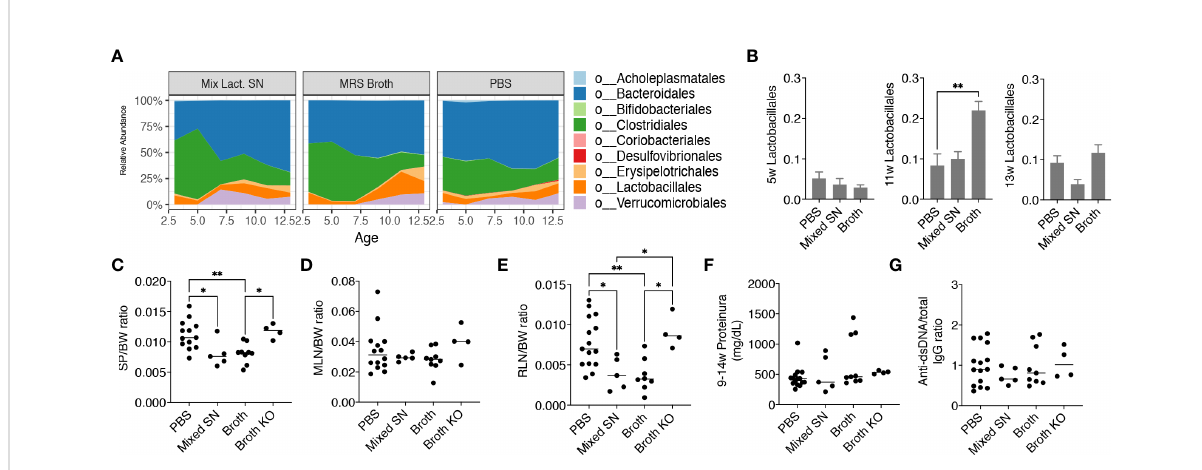
FIGURE 3 Lactobacillus spp. attenuate splenomegaly and renal lymphadenopathy through secreted factors and a CX 3 CR1-dependent mechanism. Female MRL/ lpr mice were orally gavaged with PBS, the combined culture supernatant of the 5 Lactobacillus spp. (Mixed SN), or MRS broth (Broth) twice a week at 200 m L/mouse from 3 weeks to 15 weeks of age. In some experiments, female MRL/ lpr-Cx3cr1 gfp/gfp mice were treated with MRS broth (Broth KO) following the same protocol. (A) Time-dependent changes of fecal microbiota (n=5 mice per group). (B) The relative abundance of the order Lactobacillales at 5, 11 and 13 weeks of age. (C) SP-to-body weight ratio. (D) MLN-to-body weight ratio. (E) RLN-to- body weight ratio. (F) Accumulated level of proteinuria from 9 to 14 weeks of age. (G) Anti-dsDNA-to-total IgG ratio. n ≥ 7 mice per group. Statistical signi fi cance (* p <0.05, ** p <0.01) is shown based on one-way